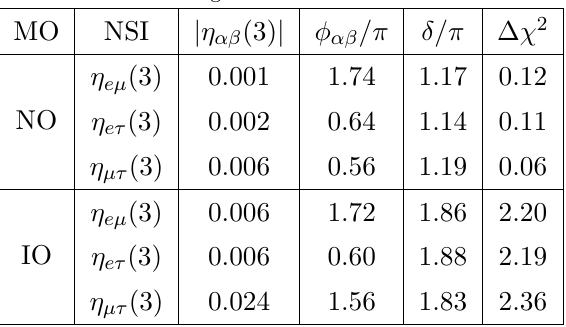
Table 7 . Best fit values to NOvA and T2K data and ∆ χ 2 = χ 2 one complex scalar NSI parameter at a time, rescaled to what it would be for a density of 3 g/cm 3 for various values of m